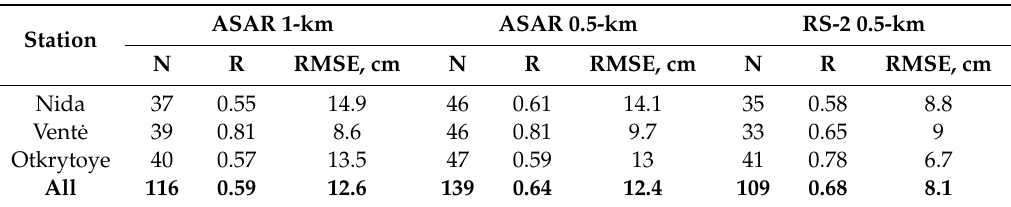
Figure 11. Scatter plots of in-situ ice thickness measurements made at Nida, Ventė and Otkrytoye stations versus ( a ) Envisat ASAR 0.5-km and ( b ) RADARSAT-2 0.5-km ice thickness products. Table 2. Statistical measures for SAR-derived ice thickness products as compared against in-situ measurements in the Curonian Lagoon.